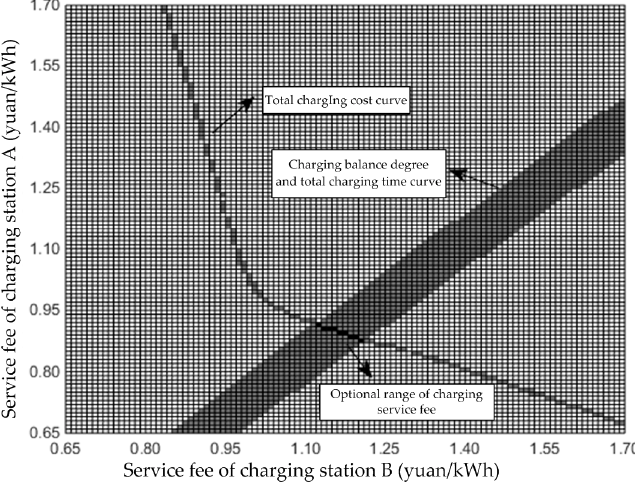
Figure 6. Feasible domain of charging service fees.